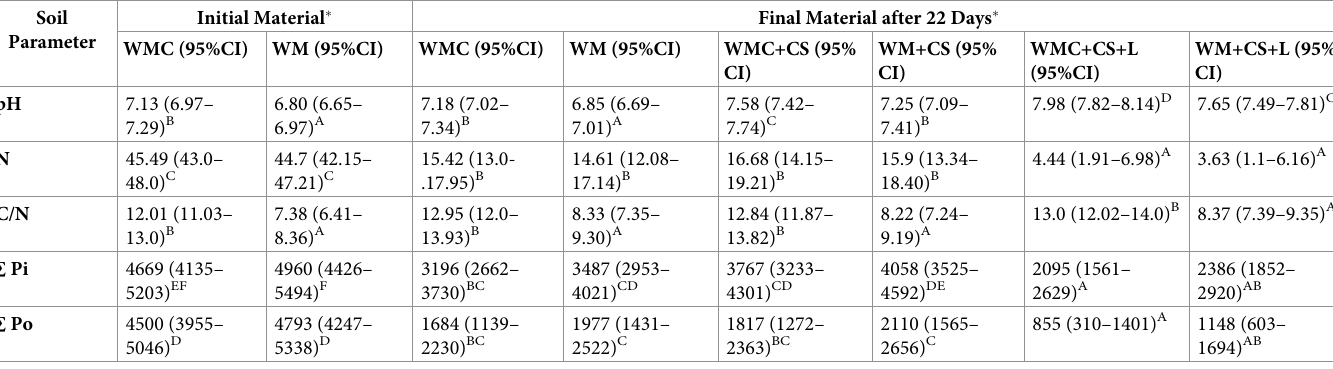
Table 2. Physicochemical parameters of the organic waste materials at the beginning and after 22 days after adding black soldier fly larvae. Soil